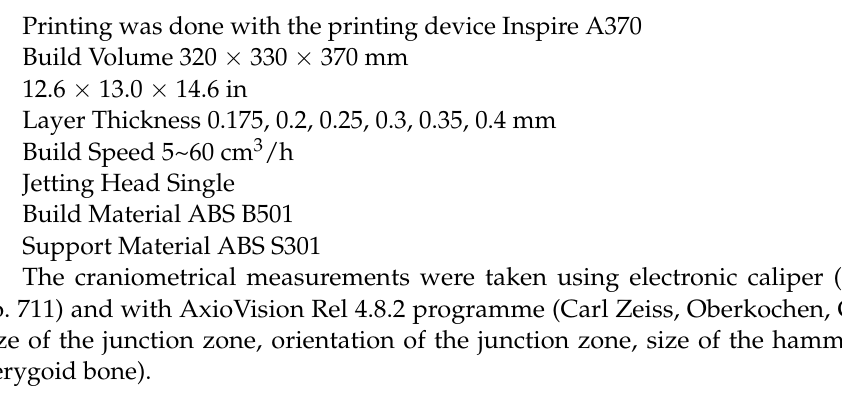
Table 1. Summary of anatomical measurement results for the whole examined group.